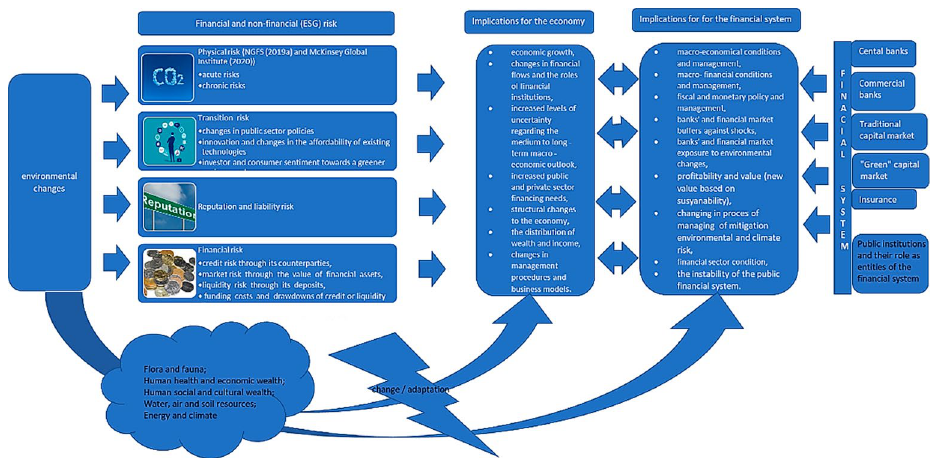
Figure 4. Sustainable finance model – environmental